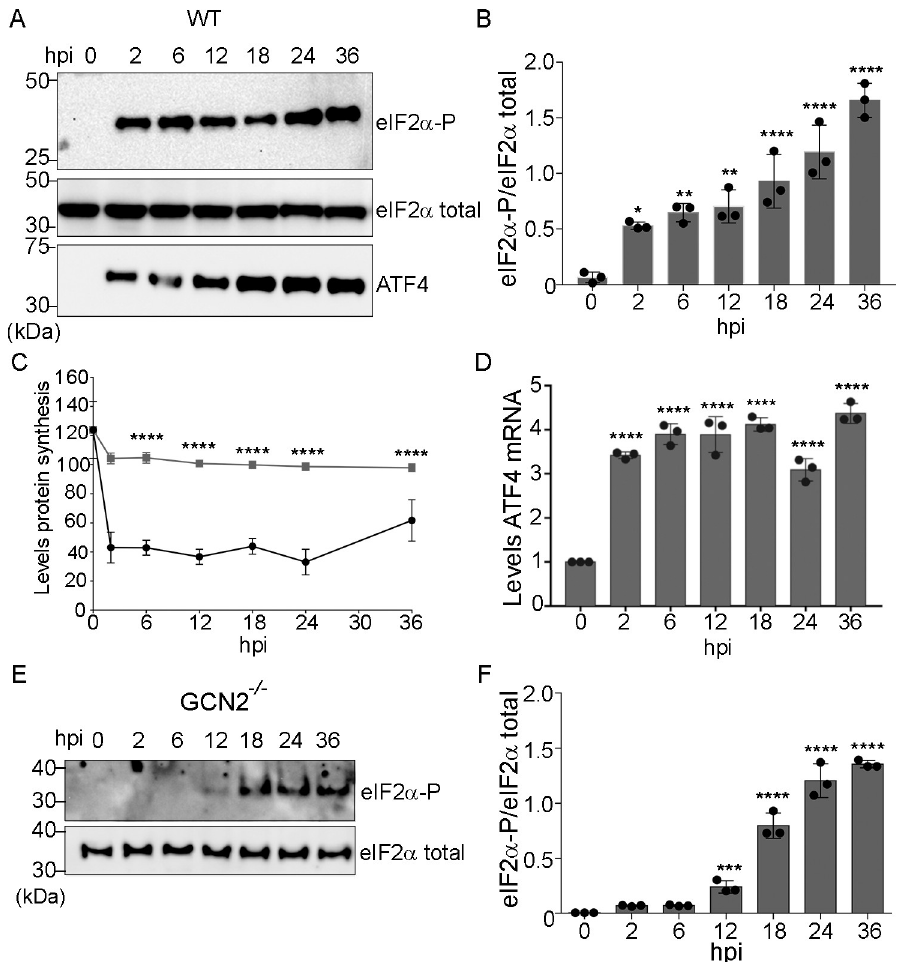
Fig 1. Toxoplasma infection triggers activation of GCN2 and induced eIF2 α phosphorylation in host cells. (A) Wild-type (WT) MEF cells were infected with Toxoplasma using a MOI of 3:1. At the indicated hpi, infected cells were harvested and the levels of eIF2 α -P, total eIF2 α , and ATF4 were measured by immunoblot. (B) Bar graph showing the levels of eIF2 α -P normalized for total eIF2 α at each of the infection time points. Amounts of eIF2 α -P were normalized to total eIF2 α ( ± SD, n = 3) � p < 0.01, �� p < 0.005, ���� p < 0.0001. (C) Total protein synthesis was measured in MEF cells infected with Toxoplasma (black, circles) or mock-infected (grey, squares) for the indicated time. Global translation was measured by incubating cells with puromycin for 15 min, followed by lysate preparation and immunoblot with puromycin-specific antibodies. The y-axis is densitometry analysis of the protein as measured by immunoblot normalized to total eIF2. ( ± SD, n = 3) ���� p < 0.0001. (D) ATF4 mRNA levels were measured by RT-qPCR; values were normalized to mock-infected cells ( ± SD, n = 3) ���� p < 0.0001. (E) GCN2 -/- MEF cells were infected for the